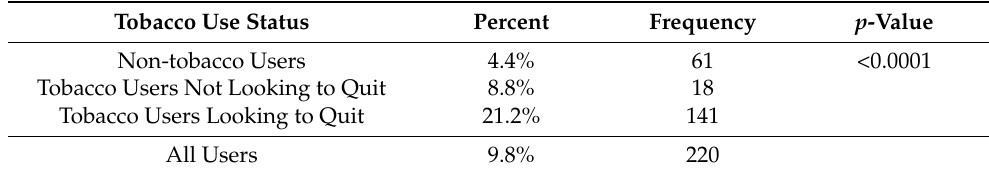
Table 3. Percent Chi-square Results of Users who Linked to Actionable Resources by Tobacco Use Status ( n =